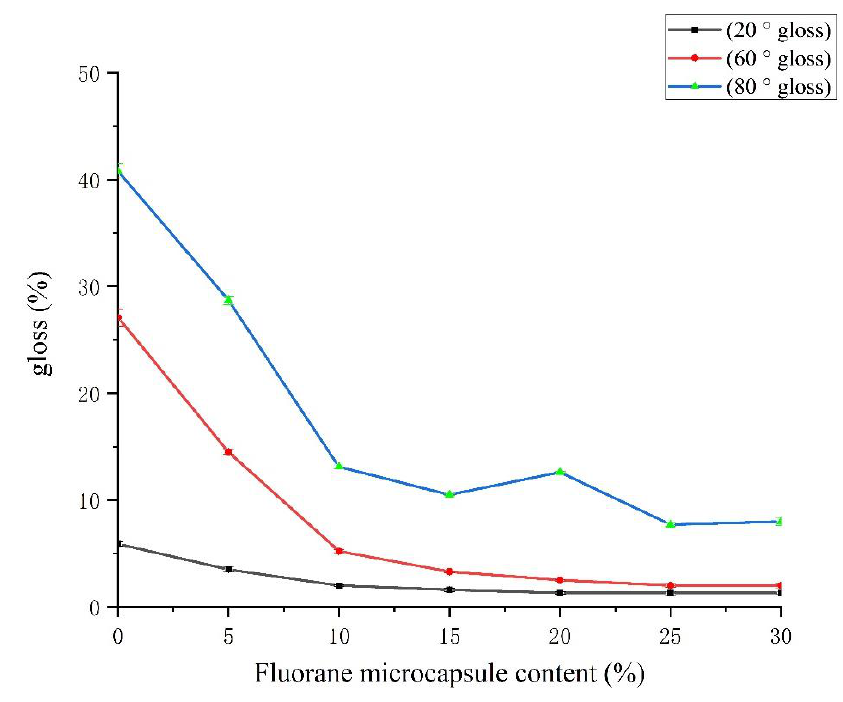
Table 6. The fluorane microcapsule content on film gloss.